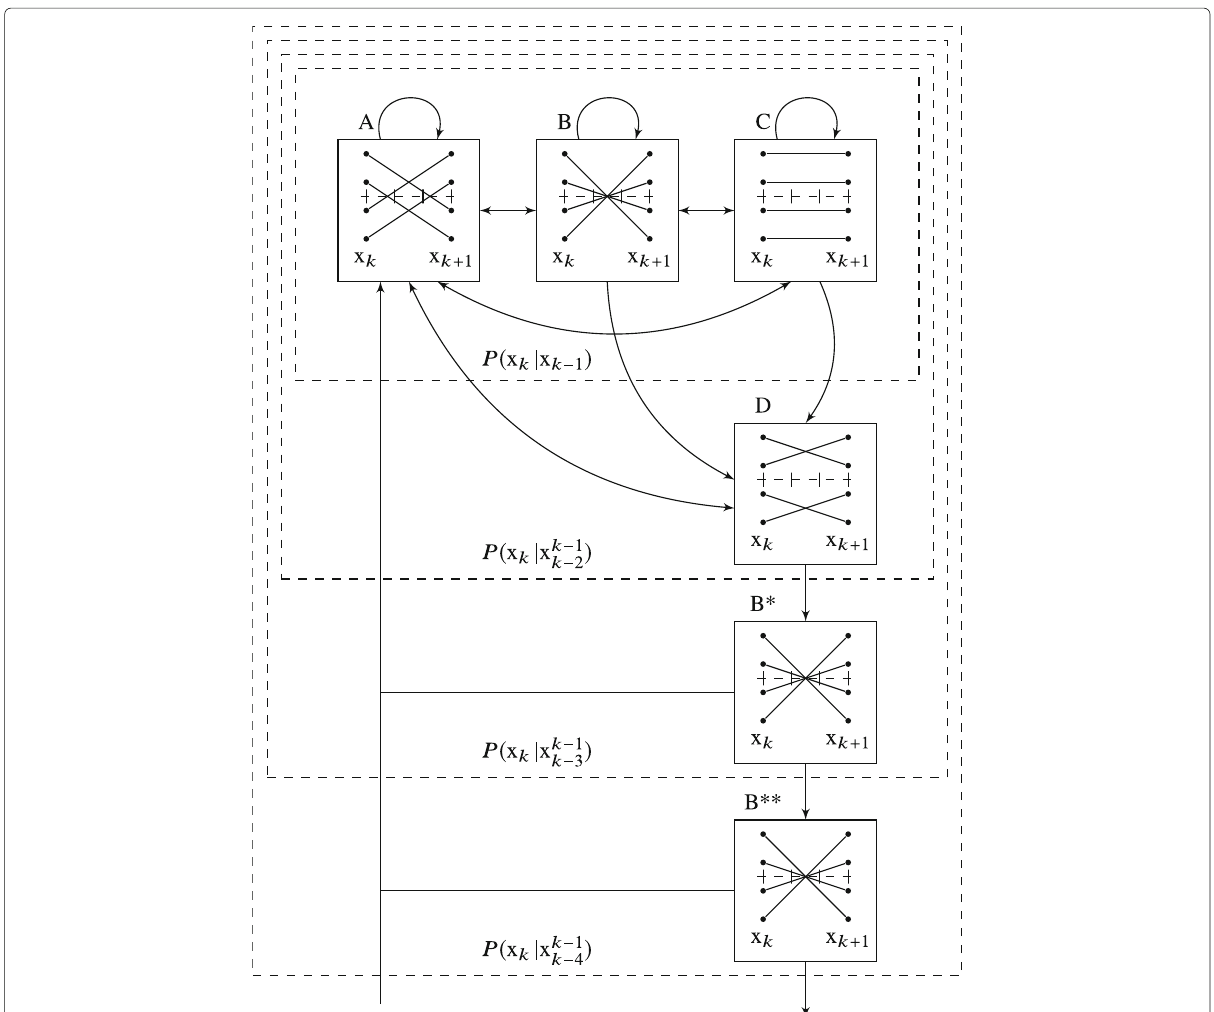
Fig. 20 State machine to generate reconstructible 4-ASK sequences with finite